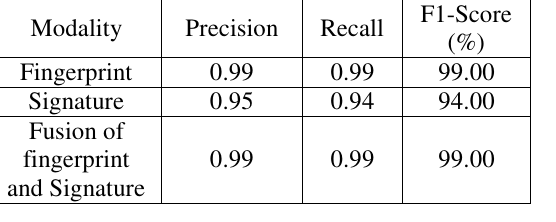
FIG. 4. CONFUSION MATRIX FOR RECOGNITION OF FINGERPRINT AND SIGNATURE